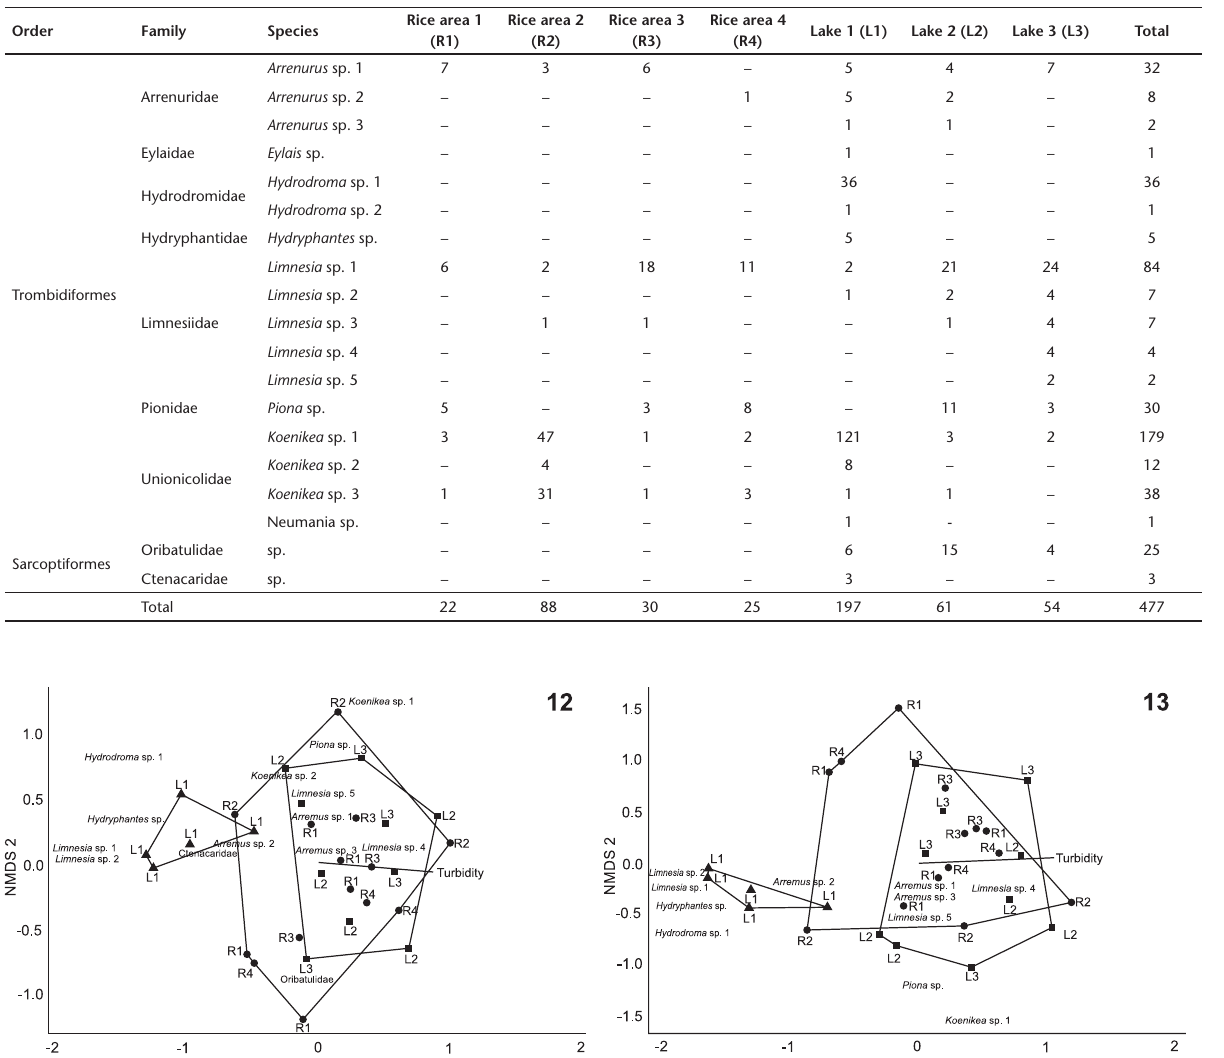
Table 2. List of water mite species and number of individuals collected (January to March/2015) in three lakes (L1, L2, L3) and four irrigated rice area cultivation (R1, R2, R3, R4) in Southern Brazil.